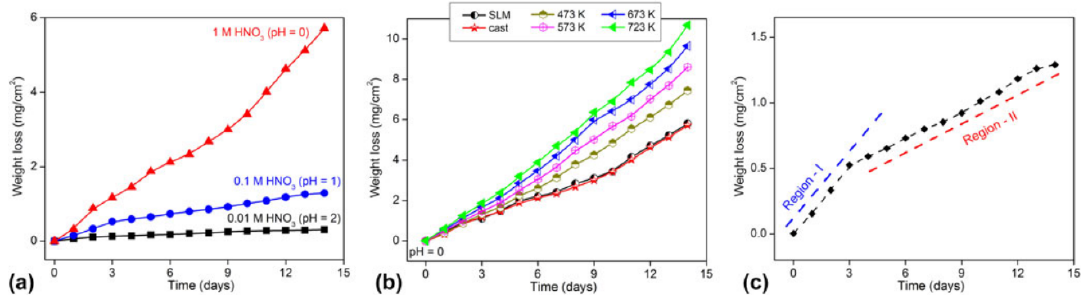
Figure 74. ( a ) Weight-loss curves for the as-prepared SLM Al-12Si samples as a function of the immersion time for three di ff erent HNO 3 concentrations (0.01, 0.1, and 1 M). ( b ) Weight-loss plots for the as-prepared SLM, cast, and SLM heat-treated samples as a function of time for the 1 M HNO 3 solution. ( c ) Weight-loss curve (black line) for the as-prepared Al-12Si SLM samples for 0.1 M HNO3, showing the di ff erent rates (rate 1—blue line and rate 2—red line) of corrosion as a function of the immersion time [205]. Copyright 2014. Adapted with permission from Cambridge University